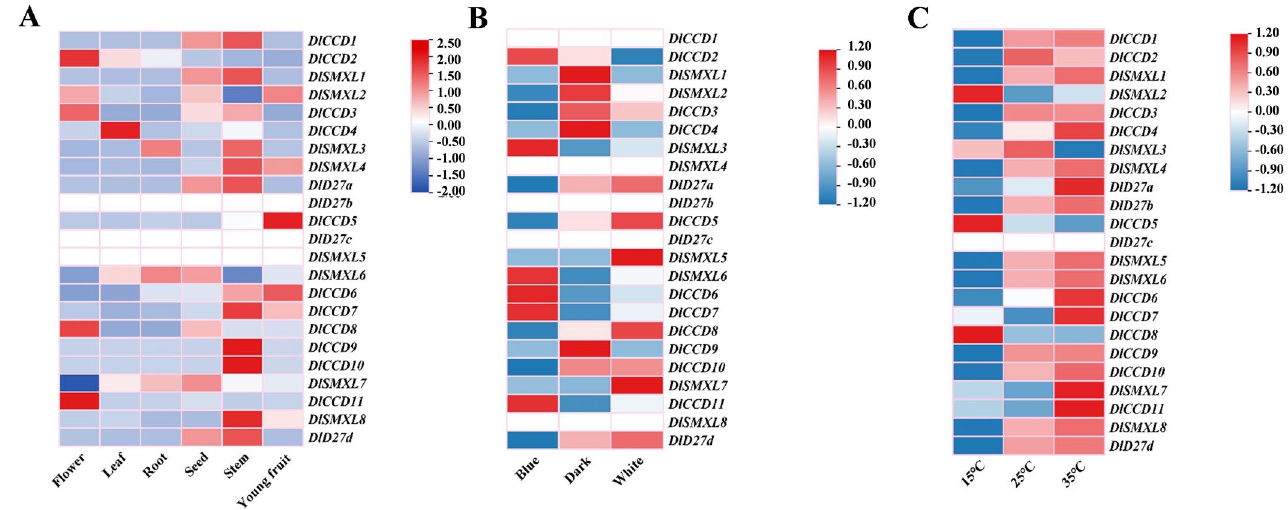
Figure 4. The expression profiling of DlCCD, DlSMXL, and DlD27 genes detected in different tissues and in response to different treatments. ( A ) Transcriptome data of DlCCD, DlSMXL, and DlD27 genes of six organs in longan. ( B ) Transcriptome data of DlCCD, DlSMXL, and DlD27 genes in the ECs under different light quality treatments for 25 d. ( C ) Transcriptome data of DlCCD, DlSMXL, and DlD27 genes in the ECs under different temperature treatments for 24 h.